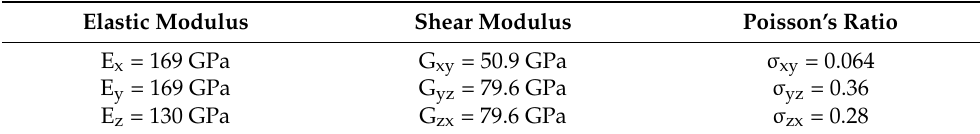
Figure 1. DIH-PnC structure: ( a ) DIH-PnC structure, ( b ) cross-like holey PnC structure. The right side is a single cell. Table 1. Properties of Materials.